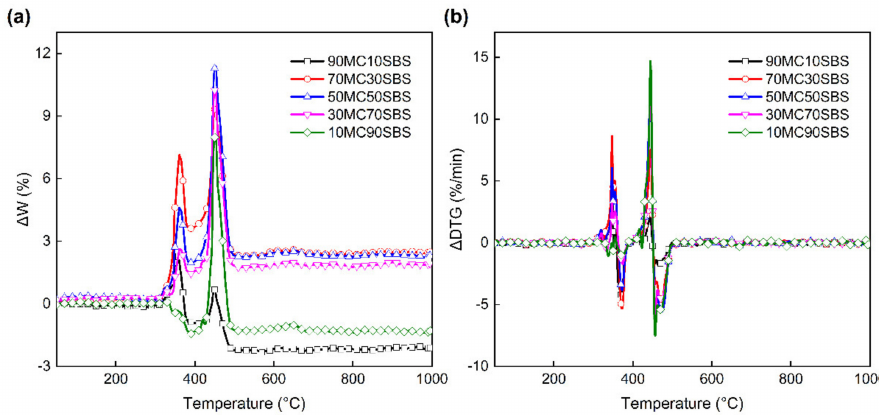
Figure 5. Co-pyrolysis interaction indices of samples with different mixing ratios (“XXMCYYSBS” means the mixed sample containing XX% MC and YY% SBS). ( a ) ∆ w ; ( b ) ∆